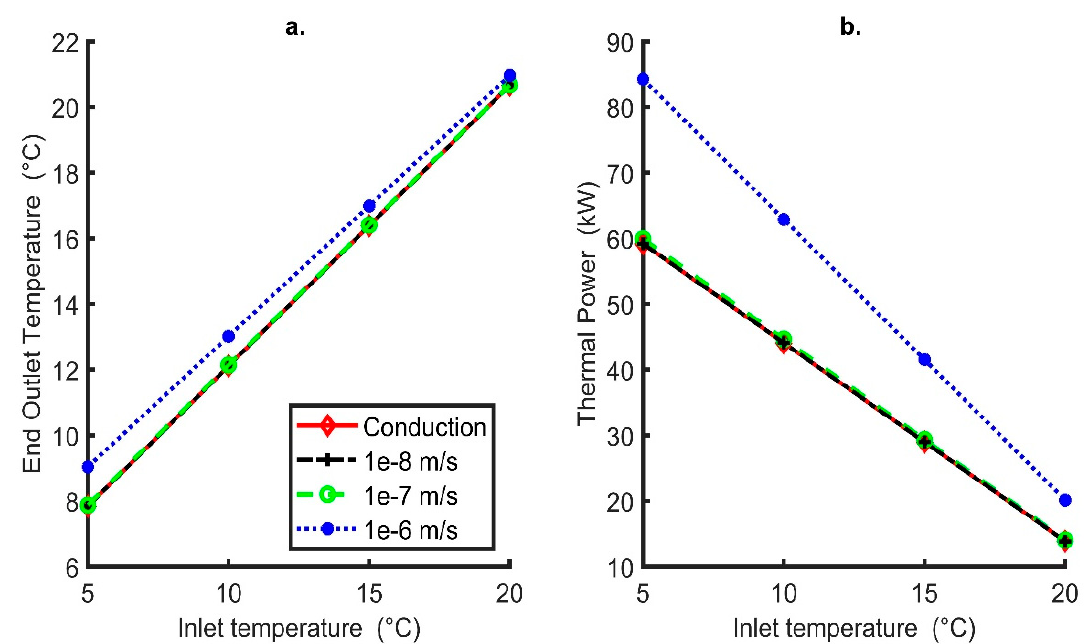
Figure 6. Six-month simulation of heat extraction only from DBHE, with constant inlet temperature and internal fluid flow rate of 5 L/s. ( a ) shows the impact of varying DBHE constant inlet tempera- ture and groundwater Darcy velocity on DBHE outlet temperature; ( b ) shows the impact on final thermal output from DBHE after 6 months. Groundwater Darcy velocity is varied between 0 m/s (conduction only) and 1e-6 m/s. Outlet temperatures and thermal powers were recorded at the end of the simulation.